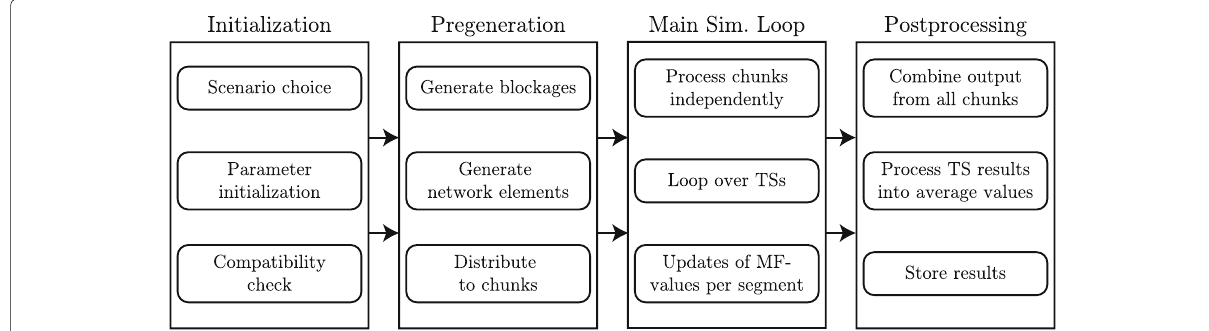
Fig. 1 Structure overview of the Vienna 5G SL simulator. The simulator is divided into four major blocks. In the figure, the main tasks that are performed per block are